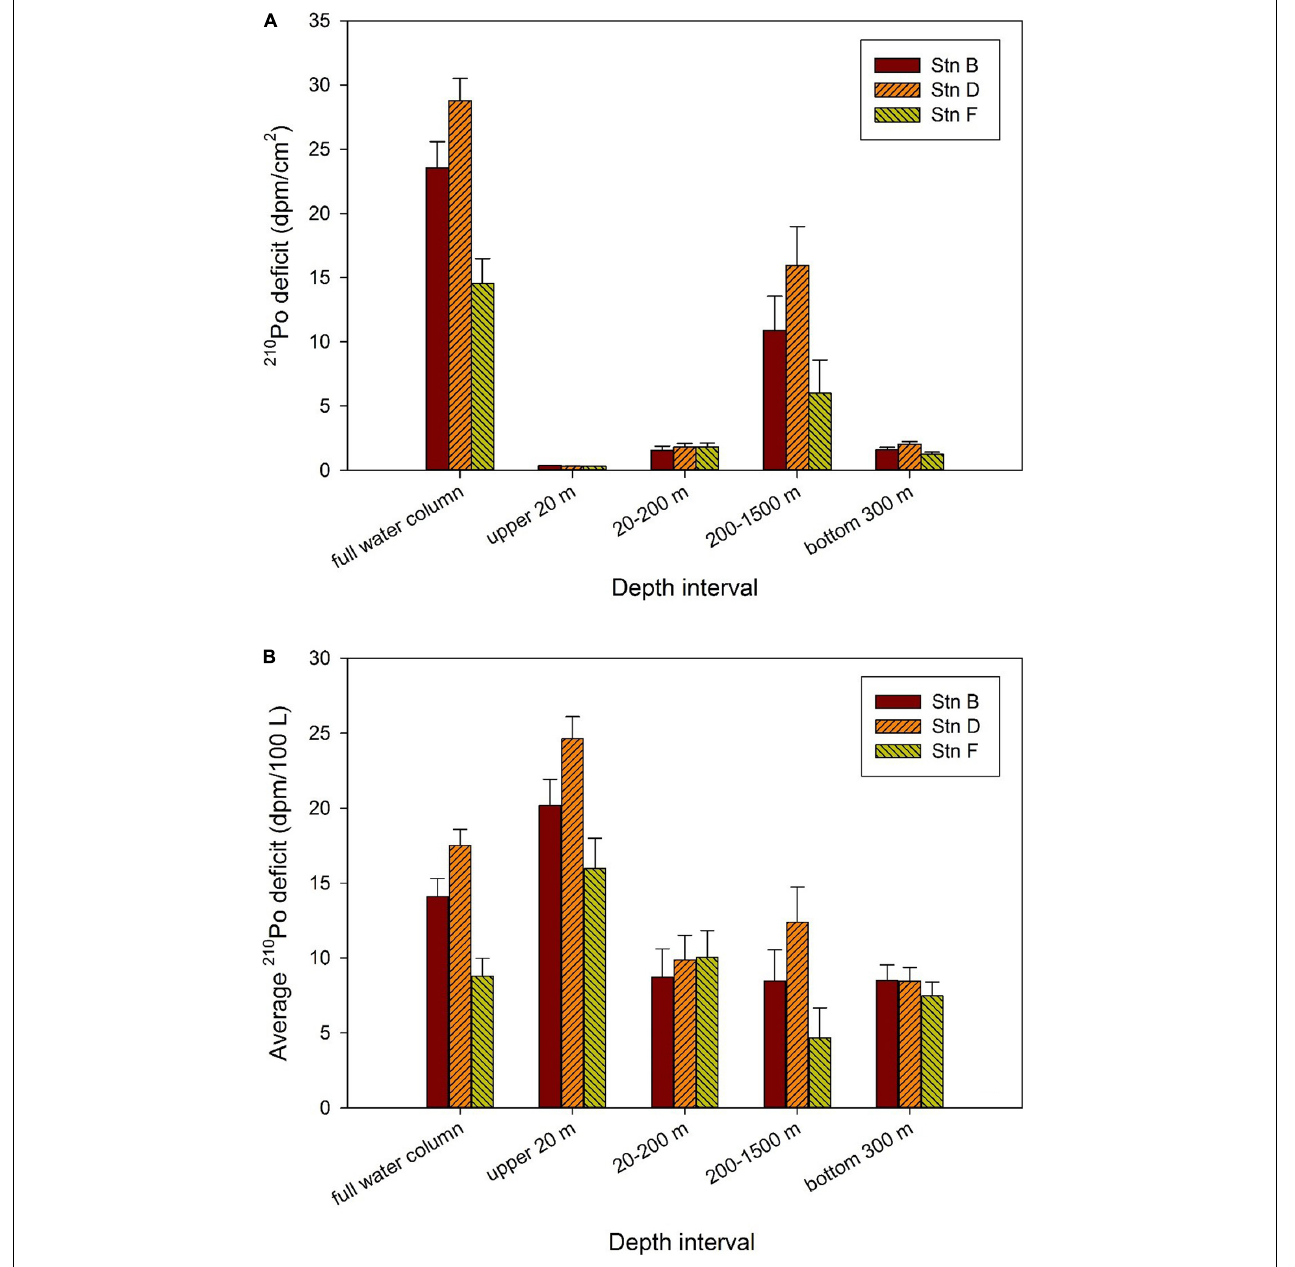
FIGURE 7 | Deficit of 210 Po in different depth intervals at the three sites. (A) Integral deficit of 210 Po; (B) average deficit of 210